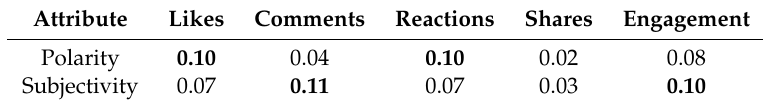
Table 6. Correlations between polarity and subjectivity and the other attributes (N =